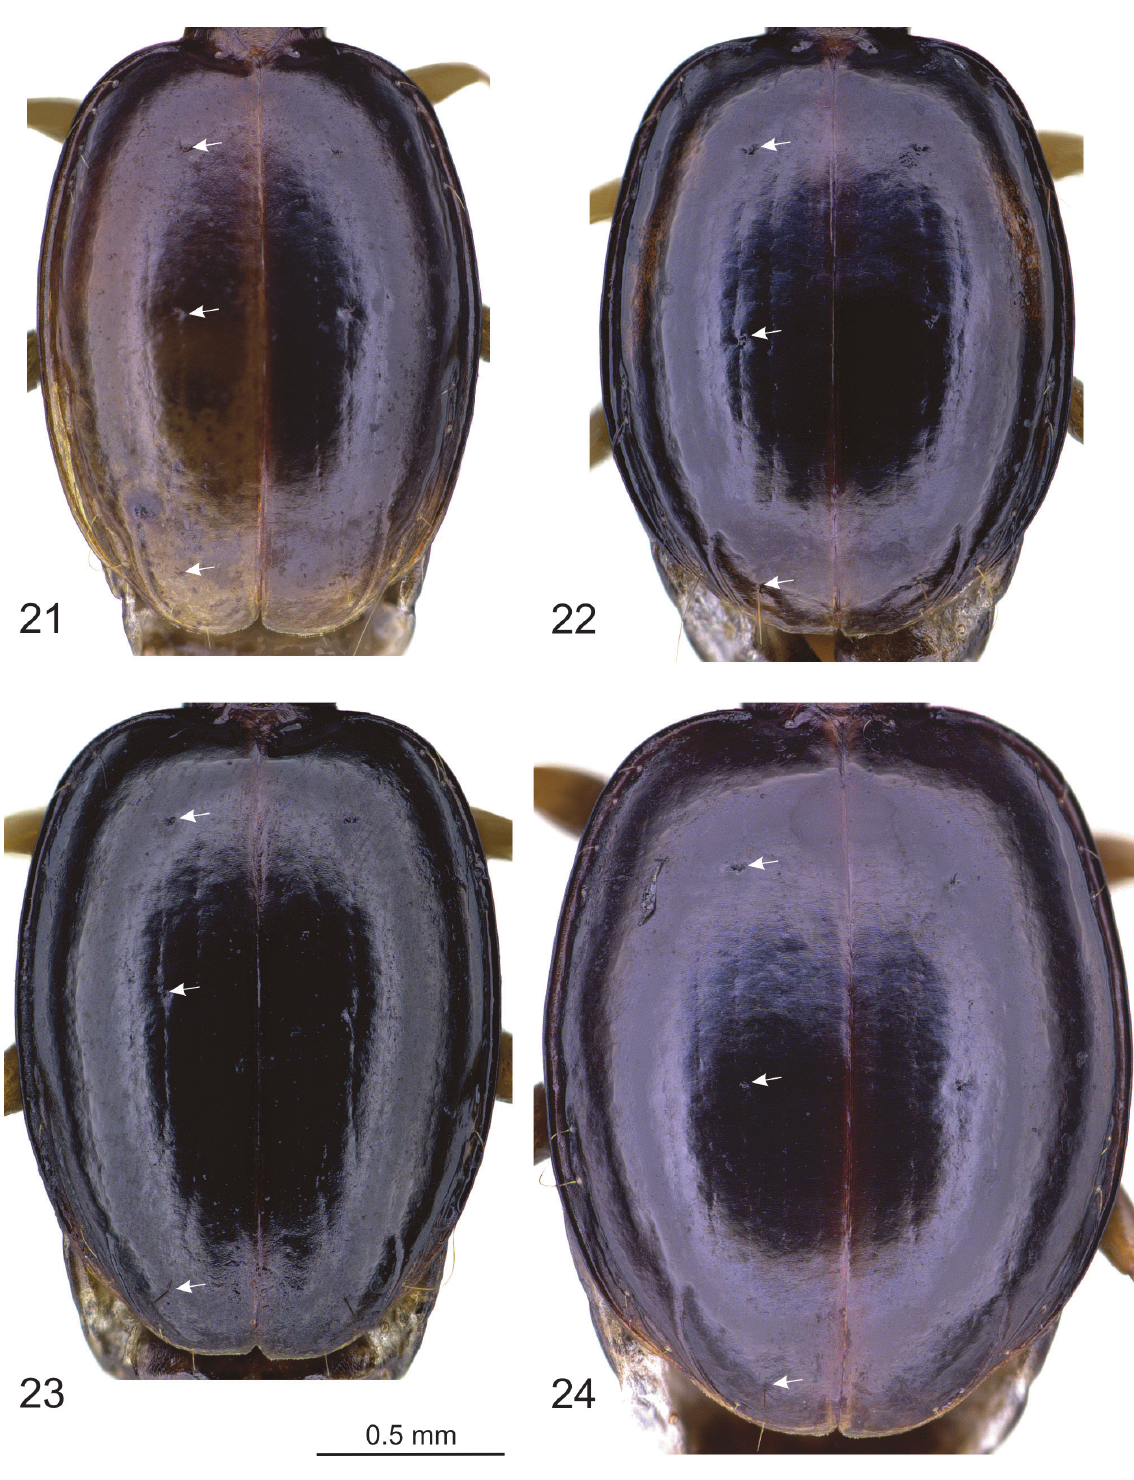
Figs 21–24. Trechus spp., elytra. 21 . T. rira sp. nov., holotype. 22 . T. iridescens sp. nov., holotype. 23 . T. oppositus sp. nov., paratype, ♂. 24 . T. bombi sp. nov., holotype. The arrows point to the insertions of the discal setae and the preapical